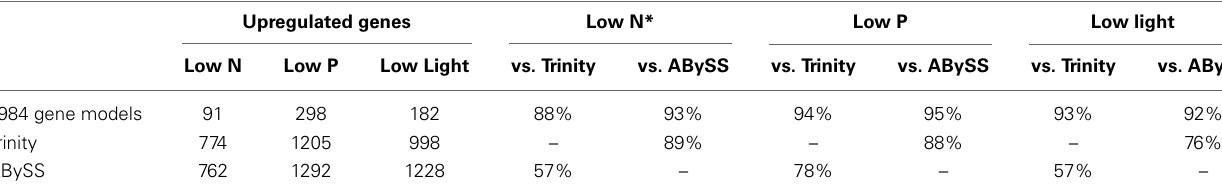
Table 4 | Significantly differentially upregulated transcripts from the mapping and assembly pipelines.